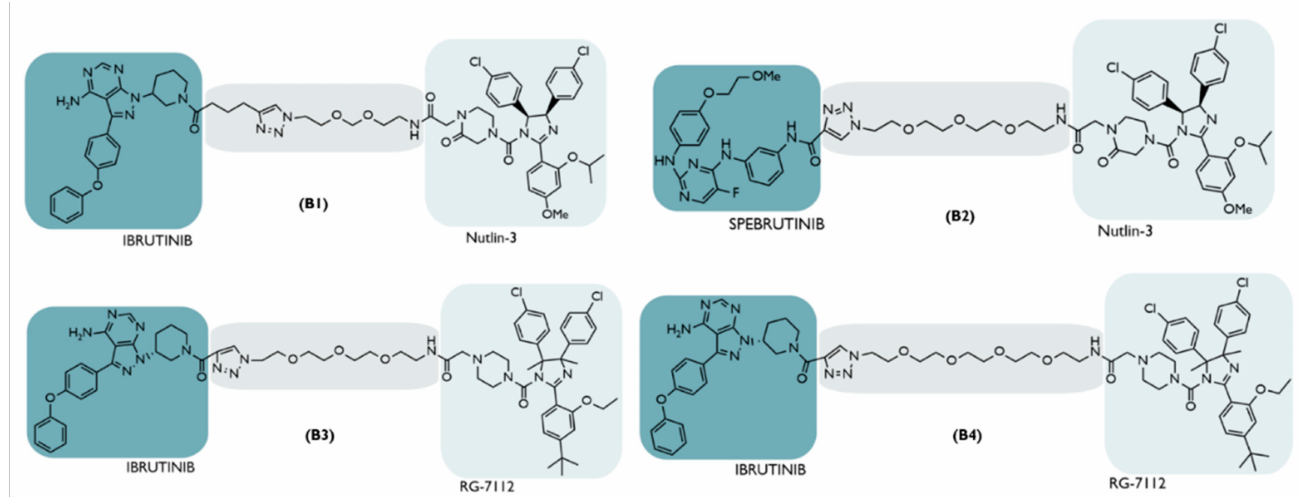
Figure 7. Chemical structures of PROTAC B. Recruiting Bruton’s tyrosine kinase (BTK) via the inhibitor ibrutinib (B1,B3,B4) or spebrutinib (B2); PROTAC B degrades the target, recruiting MDM2 via nutlin-3 (B1,B2) or the inhibitor RG-7112 (B3,B4)